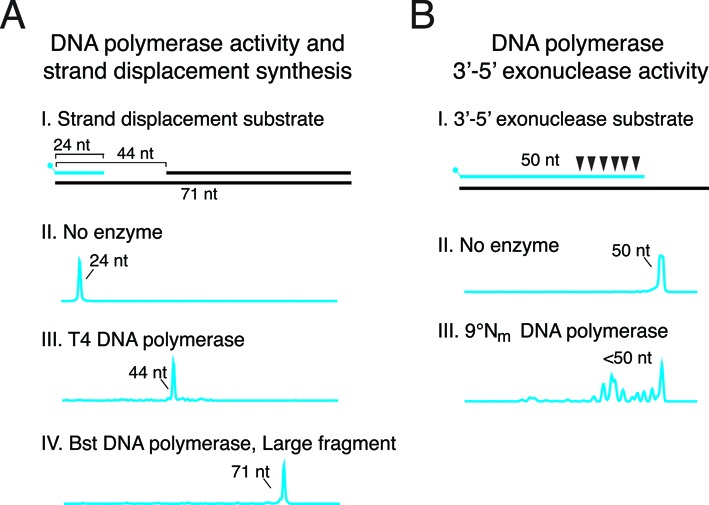
DNA polymerase strand displacement synthesis and 3′-5′ exonuclease activity. (A) T4 DNA polymerase or Bst DNA polymerase, Large Fragment strand displacement synthesis was monitored by extension of a 5′-FAM-labeled primer/template in the presence of a blocking primer 20 nt away from the extension primer. Reaction products were analyzed by capillary gel electrophoresis. (A III) T4 DNA polymerase synthesis halts upon encountering a downstream blocking oligonucleotide yielding a 44 nt extension product. (A IV) Bst DNA polymerase, Large Fragment strand displaces the blocking oligonucleotide to completely copy the 71 nt template strand. (B) 3′-5′ exonuclease activity (denoted by triangles) was monitored by incubating 9°Nm DNA polymerase and 5′-FAM-labeled primer/template. (B III) 9°Nm DNA polymerase 3′-5′ exonuclease activity degrades the 50 nt 5′-FAM-labeled primer resulting in shorter products (<50 nt).